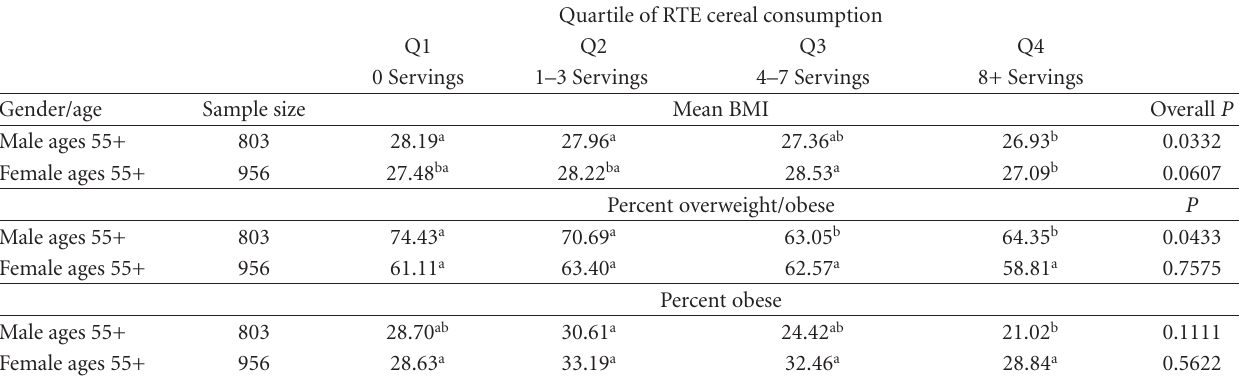
a,b Values within the same row with the same letter are not significantly di ff erent ( P < 0.05). ∗ Mean values adjusted for age, age 2